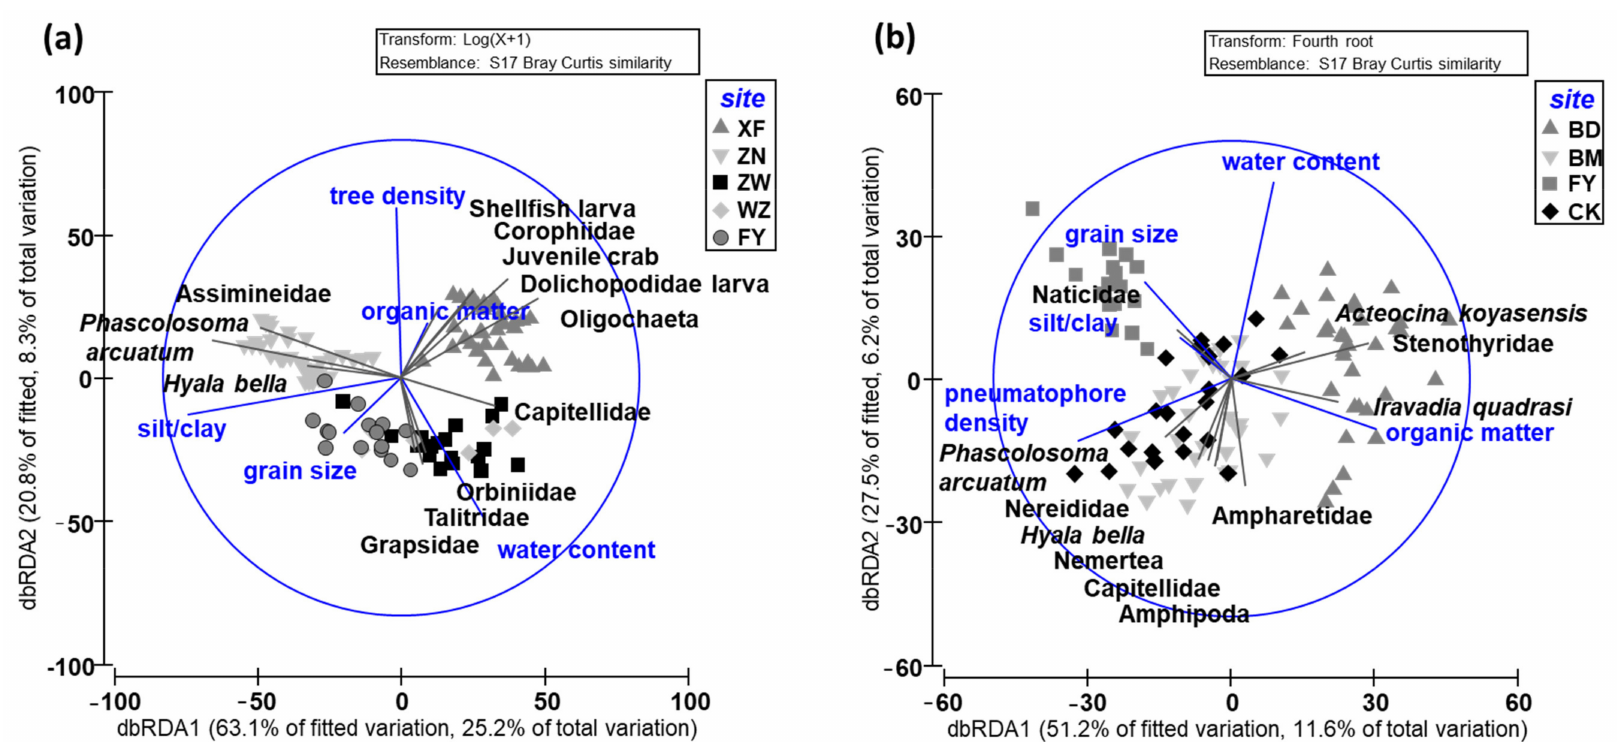
Figure 5. DistLM and dbRDA plots showing the relationships between stand structure, sediment features, and taxon density in the macrobenthic communities collected from ( a ) Kandelia obovata and ( b ) Avicennia marina mangroves of the four sites (XF, ZN, BD, and BM) sampled in this study. ZW, Huang (2017) [50]; WZ, Huang (2018) [51]; FY, Kuo (2016) [52]; CK, Yu and Lin (2015) [53]; FY, Kuo (2016) [52]. The locations of these study sites are shown in Supplementary Figure